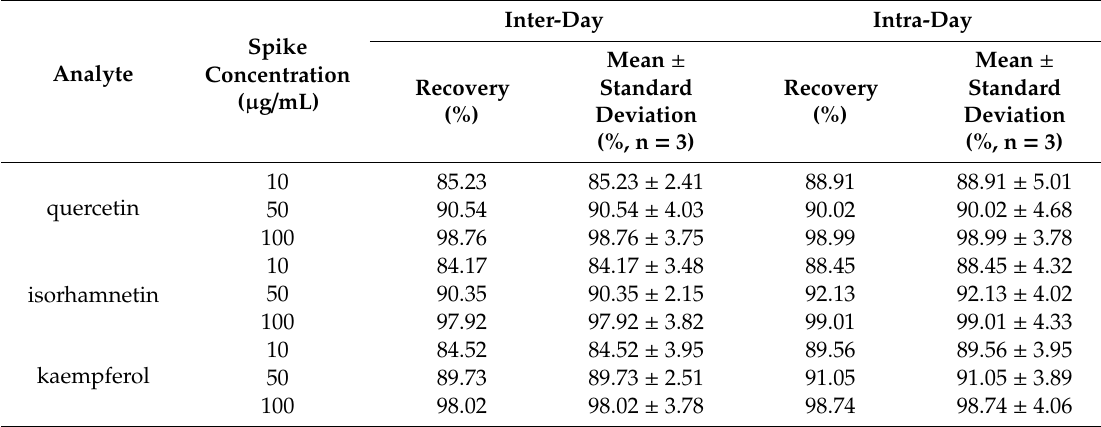
Table 2. Recovery of the spiked standard